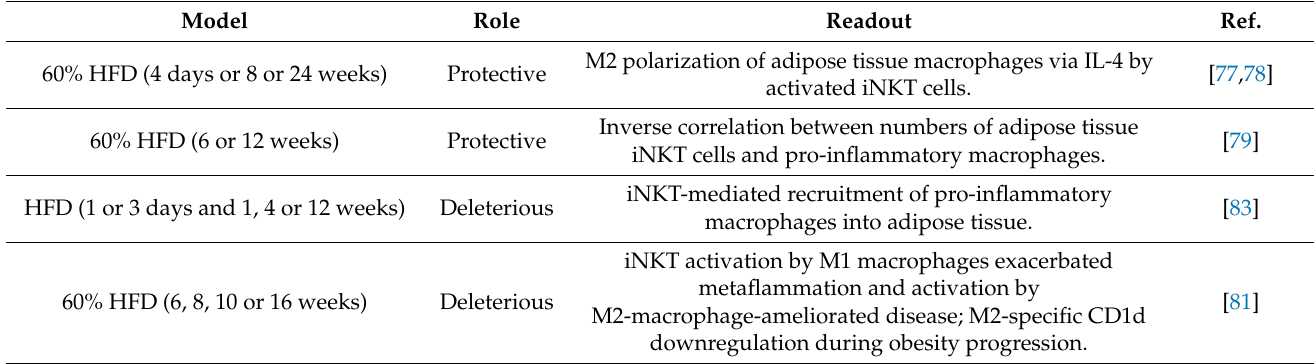
Table 2. Interactions between iNKT cells and macrophages in murine models of diet-induced obesity. Model Role Readout Ref. M2 polarization of adipose tissue macrophages via IL-4 by Protective activated iNKT cells. Inverse correlation between numbers of adipose tissue Protective iNKT cells and pro-inflammatory